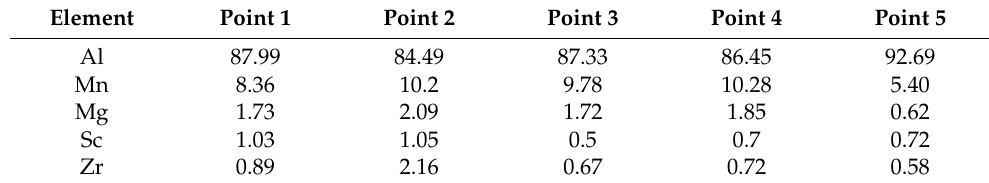
Table 4. EDS analysis of the second phases around the cracks shown in Figure 7e,f. (wt.%). Element Point 1 Point 2 Point 3 Point 4 Point